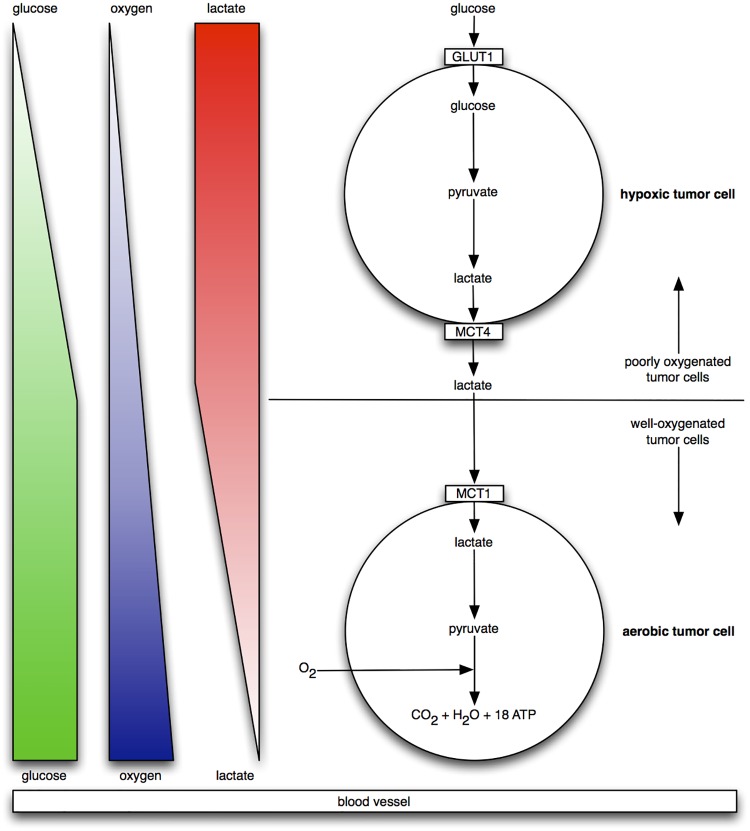
Metabolic symbiosis.A schematic view of the “metabolic symbiosis” [52, 53] between hypoxic and aerobic tumor cells, where lactate produced by hypoxic cells is taken up by aerobic cells, which use it as their principal substrate for oxidative phosphorylation. The two cell types thereby mutually regulate their access to energy metabolites. Note the orientation of glucose, oxygen, and lactate gradients with respect to the blood vessel at the bottom.